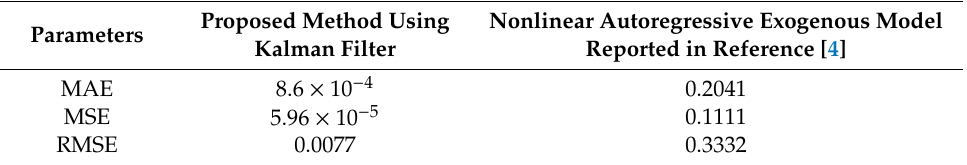
Table 4. Comparison of performance